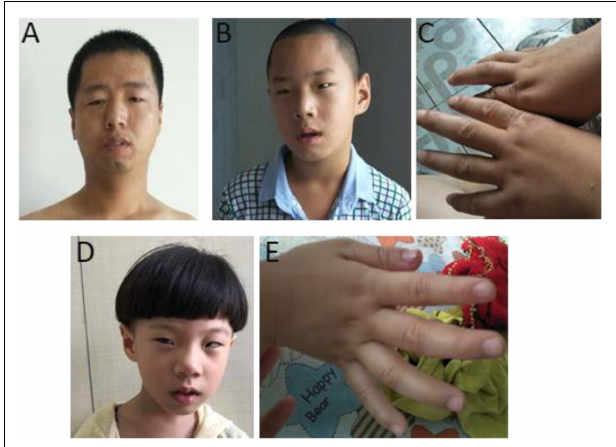
FIGURE 2 | Photos of one family with 1q21.1 deletions (cases 7–9). (A) The father with mild dysmorphic facial features and the son with intellectual disabilities, strabismus, deformed ears (B) , and tapered fingers (C) . (D,E) The daughter has intellectual disabilities. Like her elder brother, she also manifested with strabismus, pointed chin and deformed ears (D) , and tapered fingers (E)